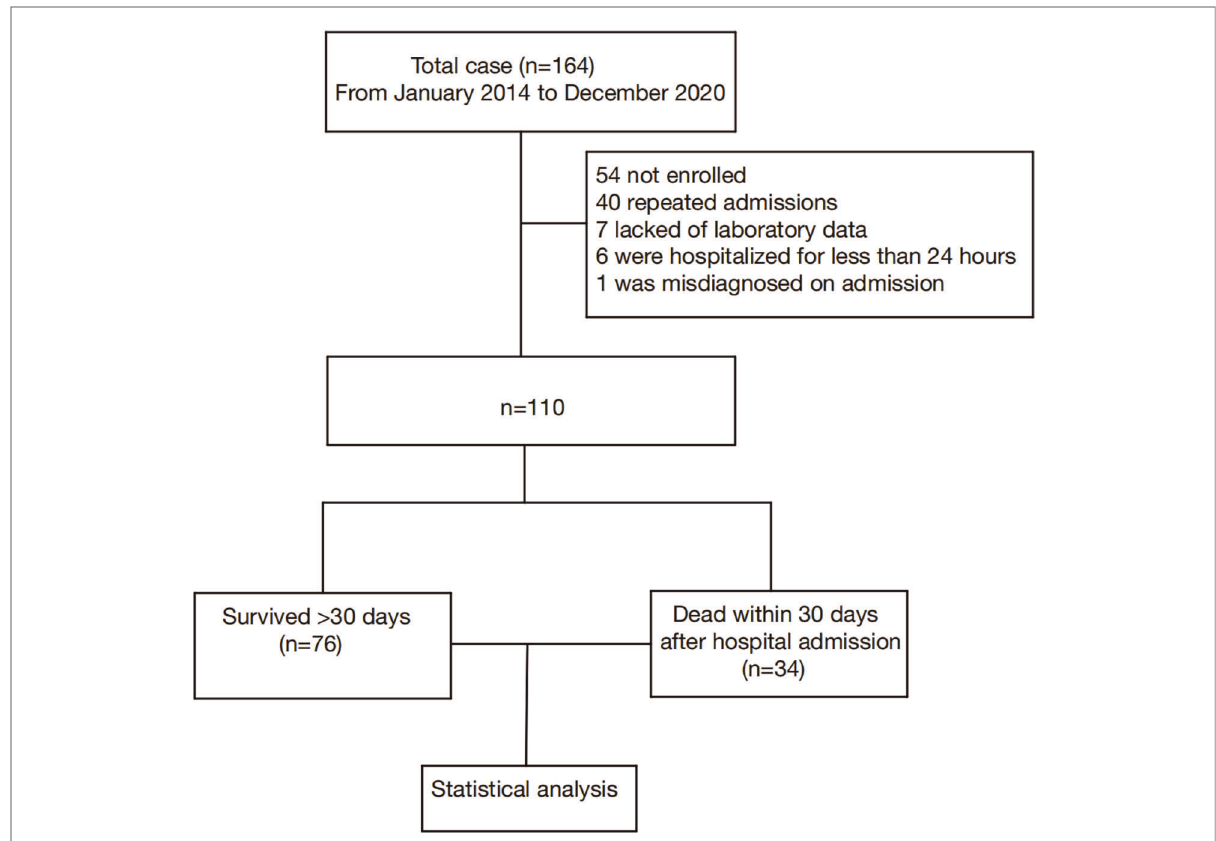
FIGURE 1 Study fl ow chart detailing the inclusion and exclusion of cases. Data collection fl ow chart for a total of 164 patients, with 110 fi nal samples and 54 excluded